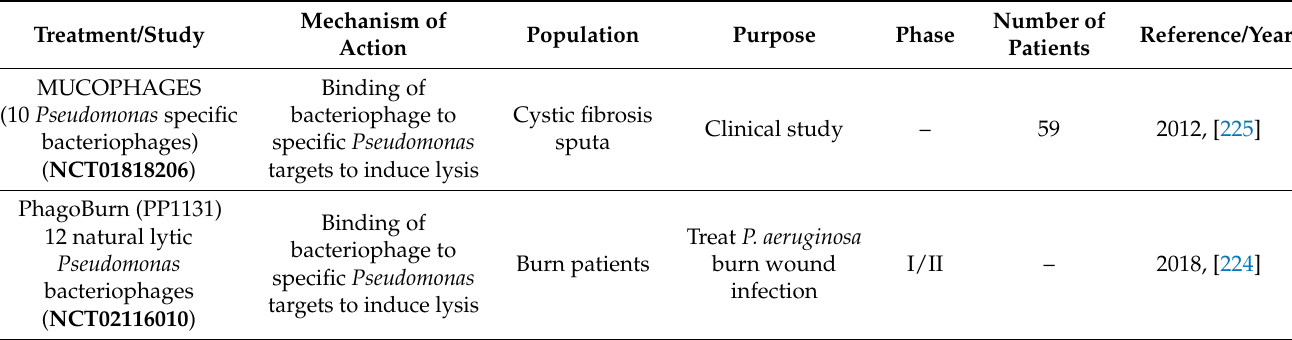
Table 2. Bacteriophage therapy for P. aeruginosa